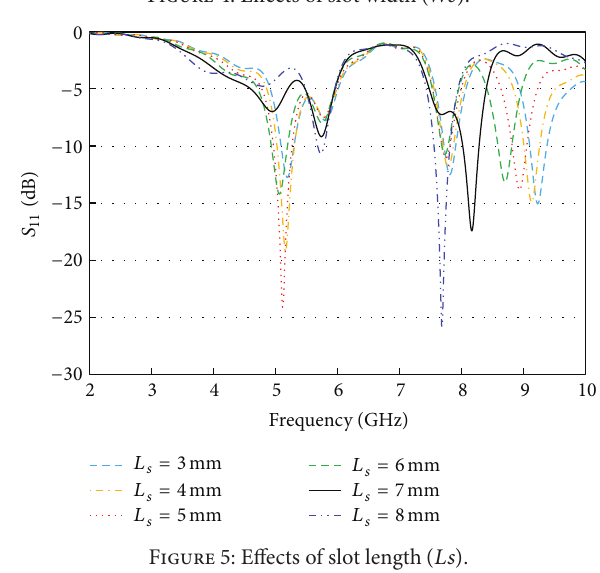
Figure 4: Effects of slot width (𝑊𝑠) .